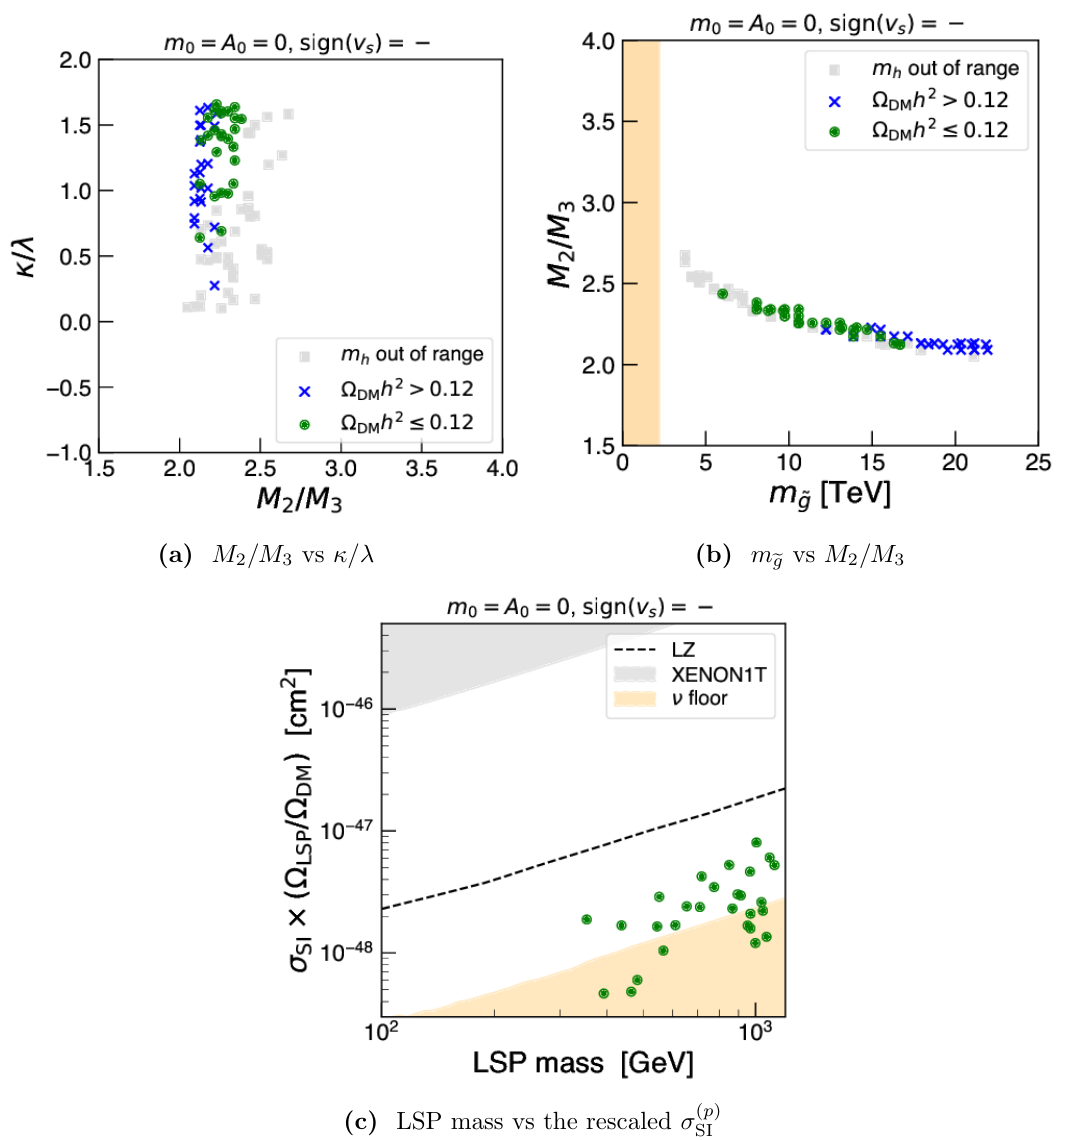
Figure 6. Scatter plots similar to (cid:12)gures 3, 4, and